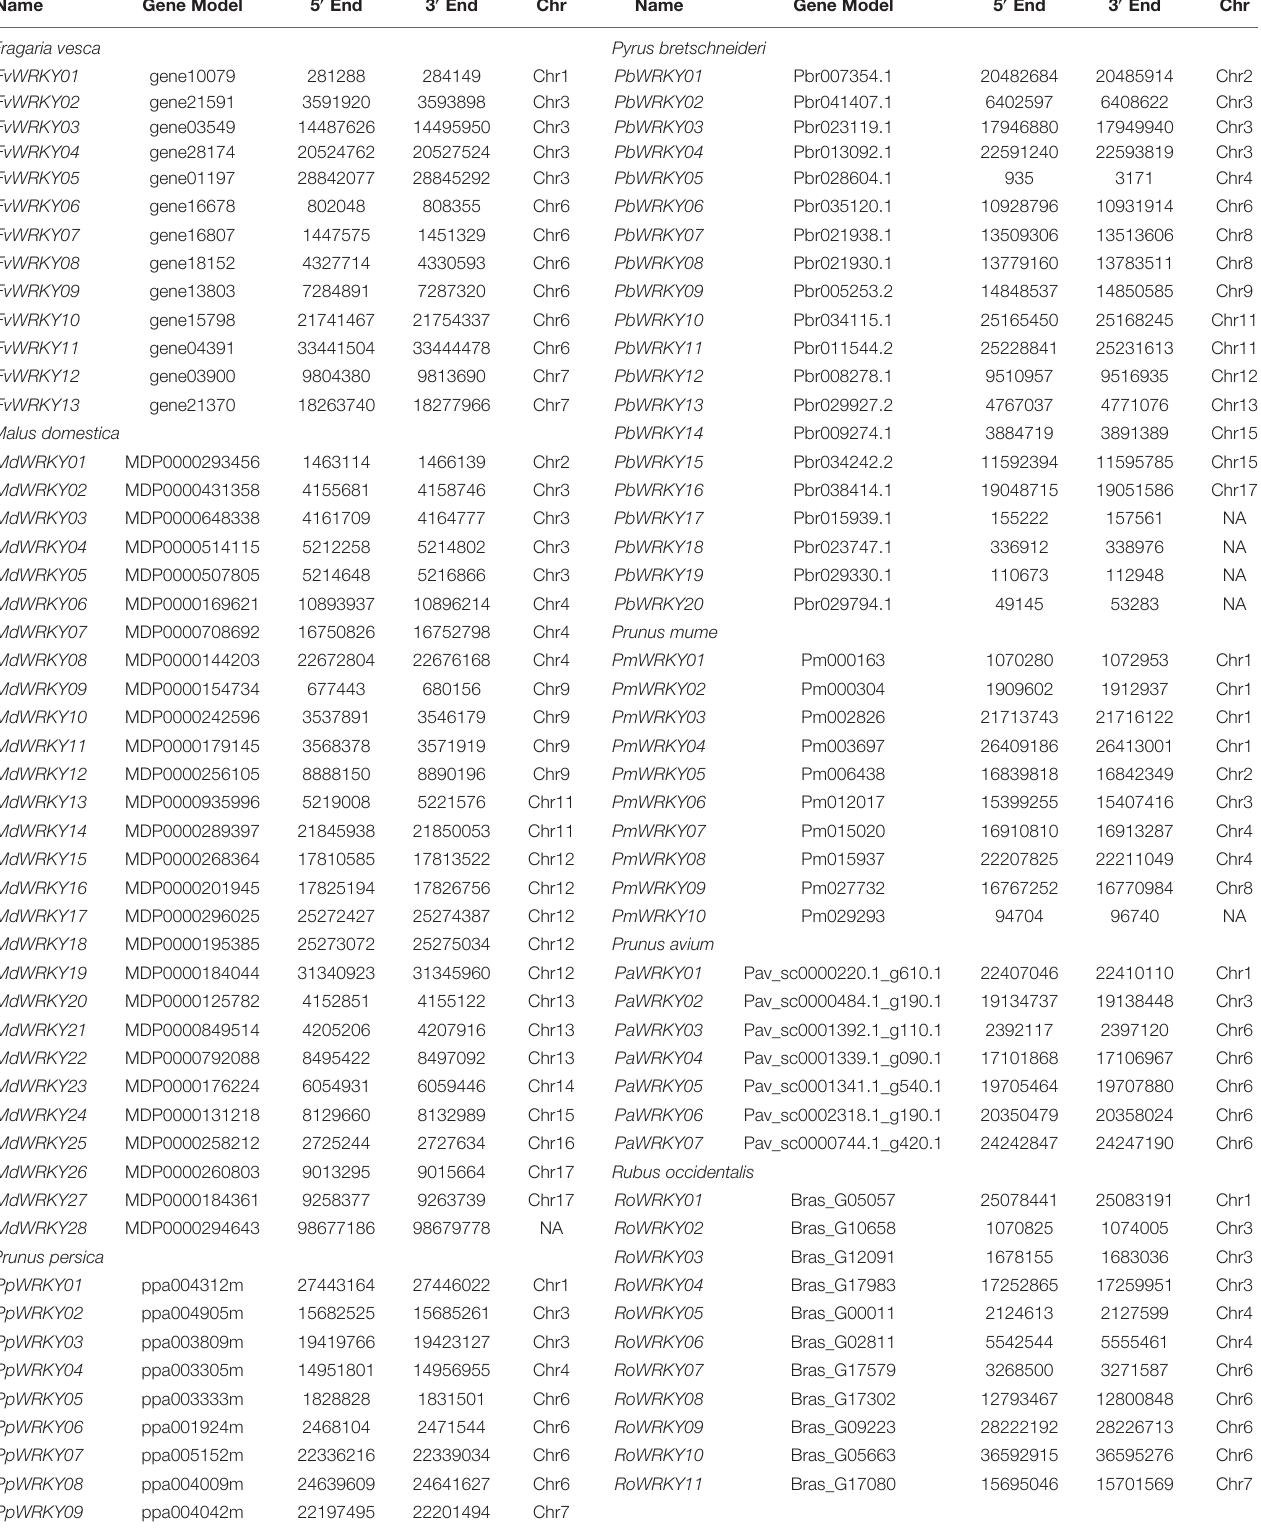
TABLE 1 | The detailed information of seven Rosaceae species WRKY I family